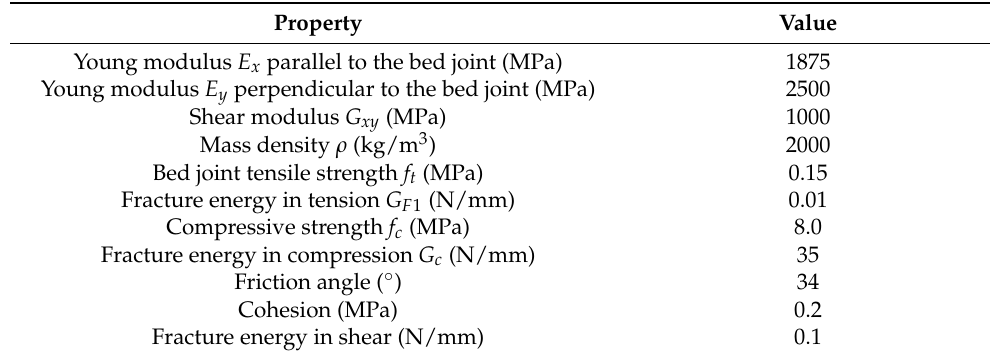
Table 8. Properties of the shell elements representing masonry walls in building B3 based on the experimental studies reported in [49,50].